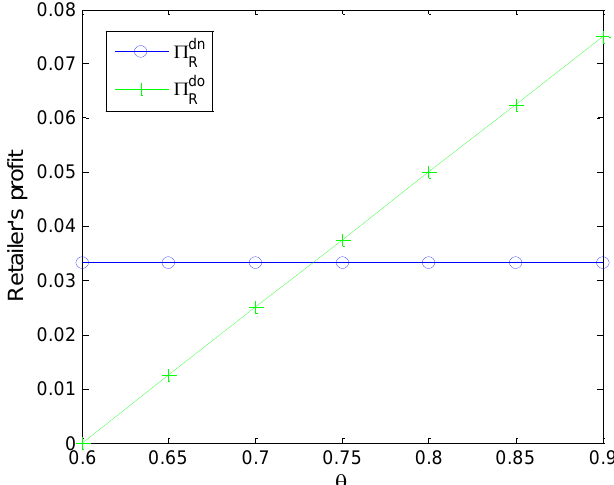
Figure 6. Impact of θ on retailer’s profits under competition case.